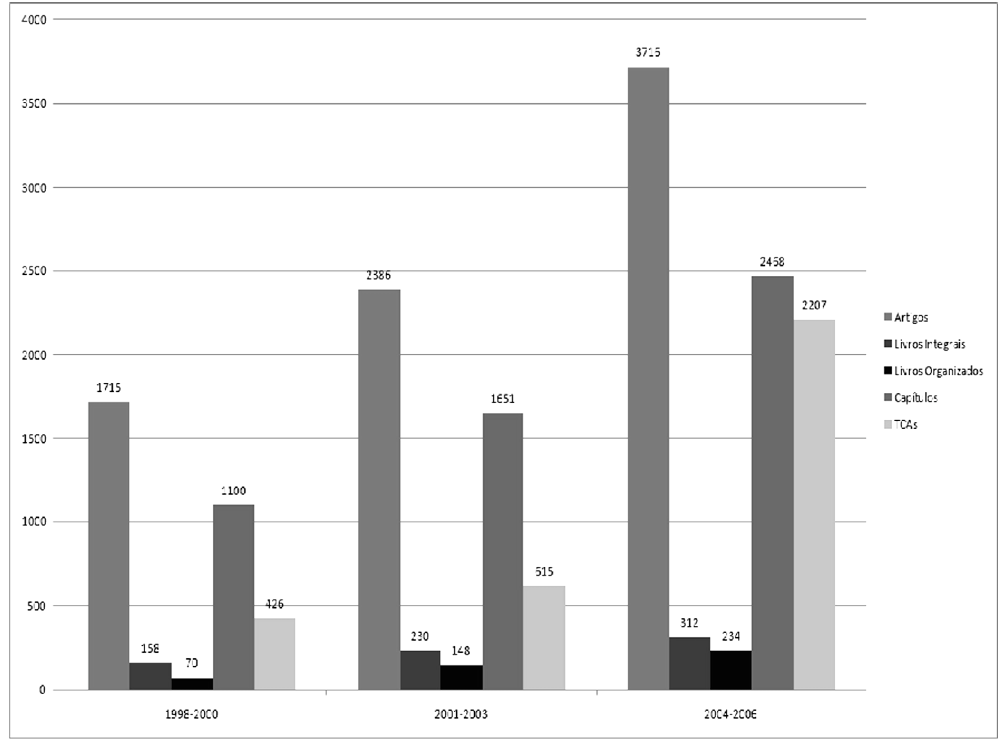
Figura 1 . Evolução da produção bibliográfica dos programas de Pós-Graduação stricto sensu da área de